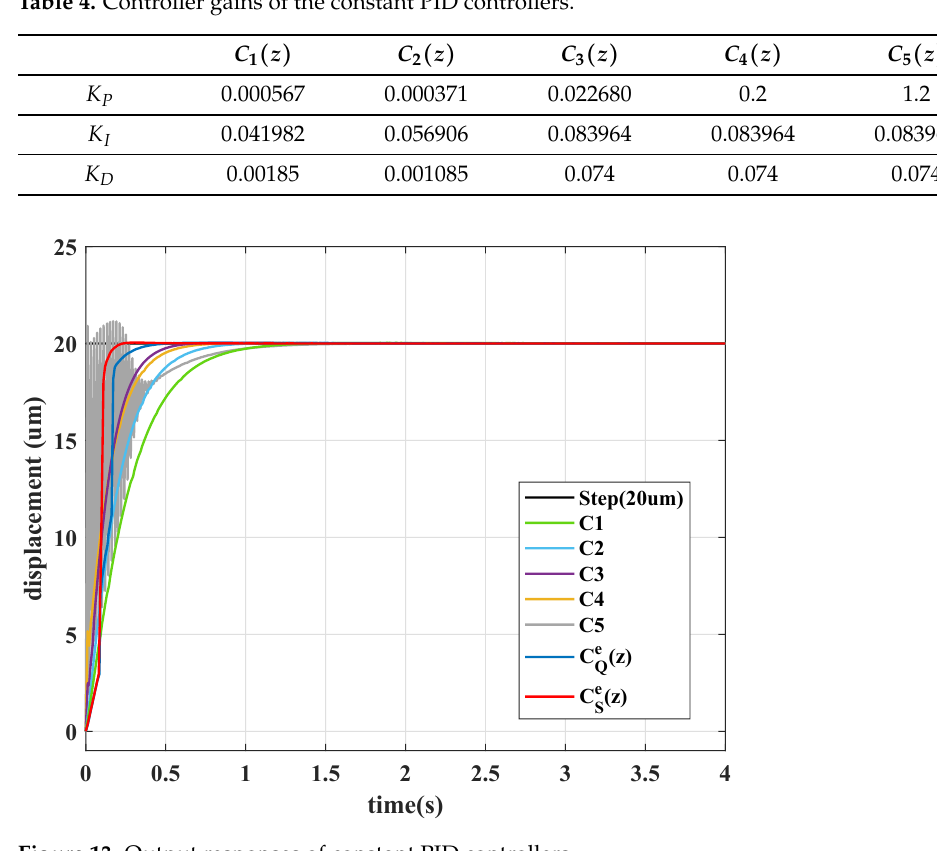
Figure 13. Output responses of constant PID